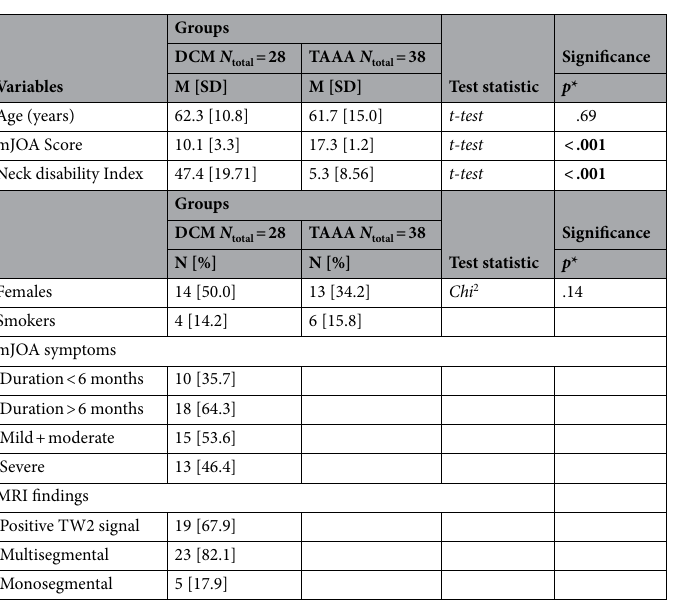
Table 1. Demographic and clinical findings of patients (DCM) and controls (TAAA). CSF cerebrospinal fluid, DCM Degenerative cervical myelopathy, M mean, mJOA modified Japanese Orthopedic Association , SD standard deviation, TAAA thoracic abdominal aortic aneurysm. Bold values indicate significance level of p <